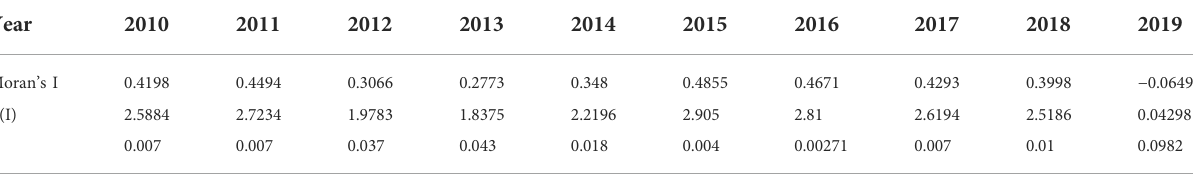
TABLE 1 Global Moran ’ s index of tourism eco-ef fi ciency in the Beijing-Tianjin-Hebei region.